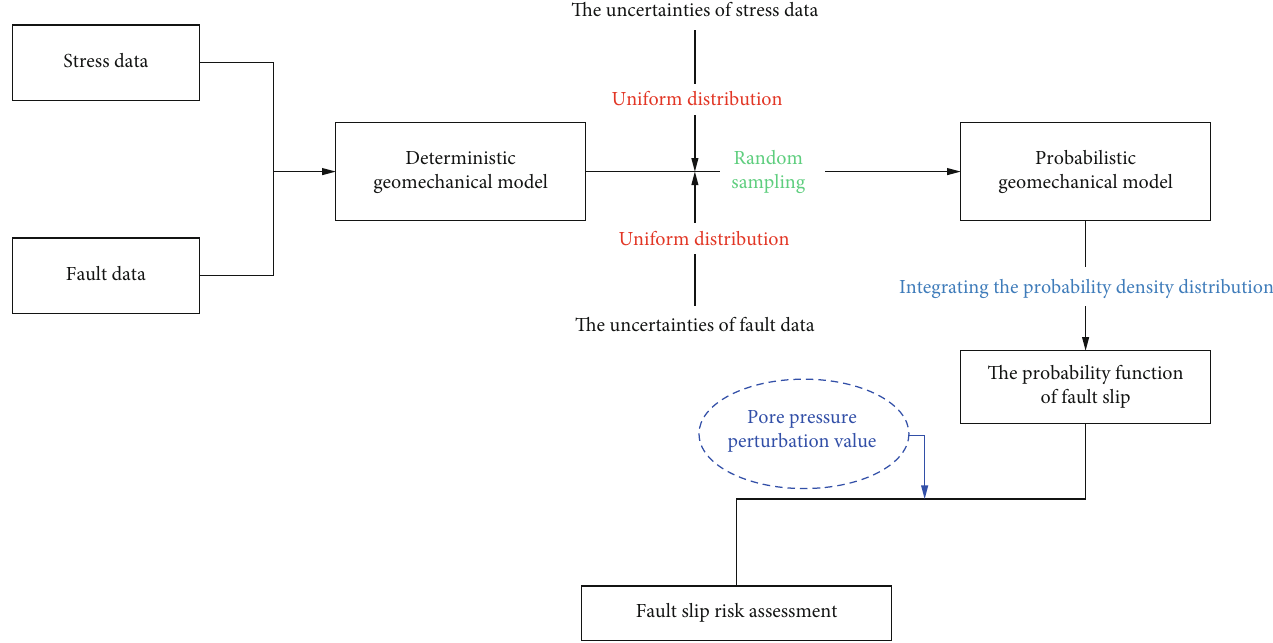
Figure 9: The risk assessment process of fault